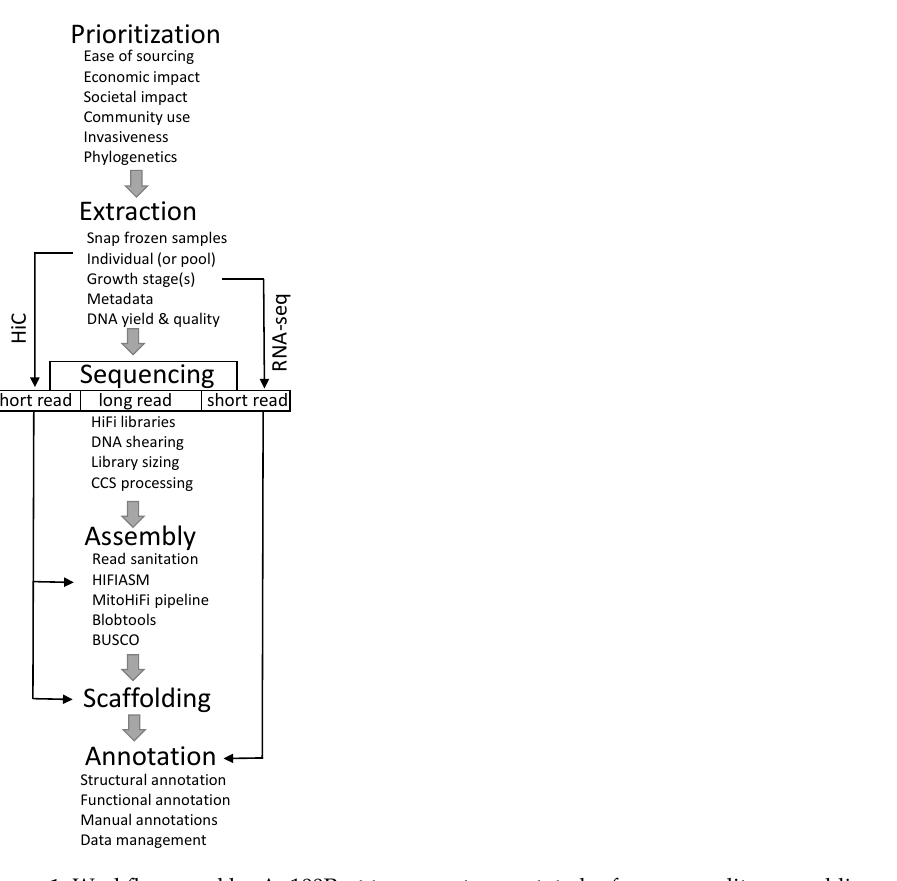
Figure 1. Workflow used by Ag100Pest to generate annotated reference-quality assemblies.